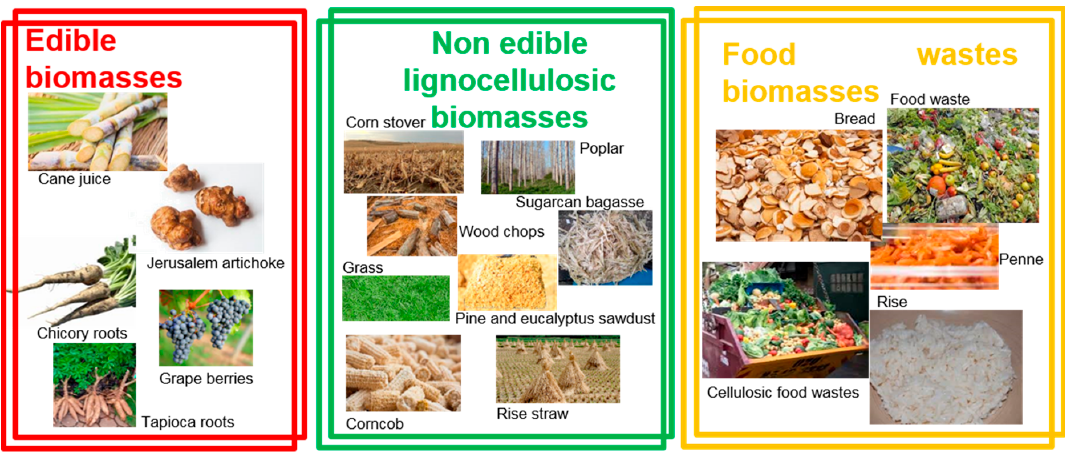
Figure 3. Schematization of the three sections of the review.